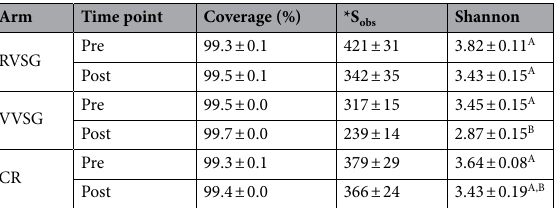
Table 2. Coverage and alpha diversity (mean ± standard error) in patient samples prior to and following VSG with routine antibiotics (RVSG), VSG with intravenous Vancomycin (VVSG), or caloric restriction (CR). *S obs —number of OTUs observed. A,B Values sharing the same superscript did not differ significantly by post- hoc test.